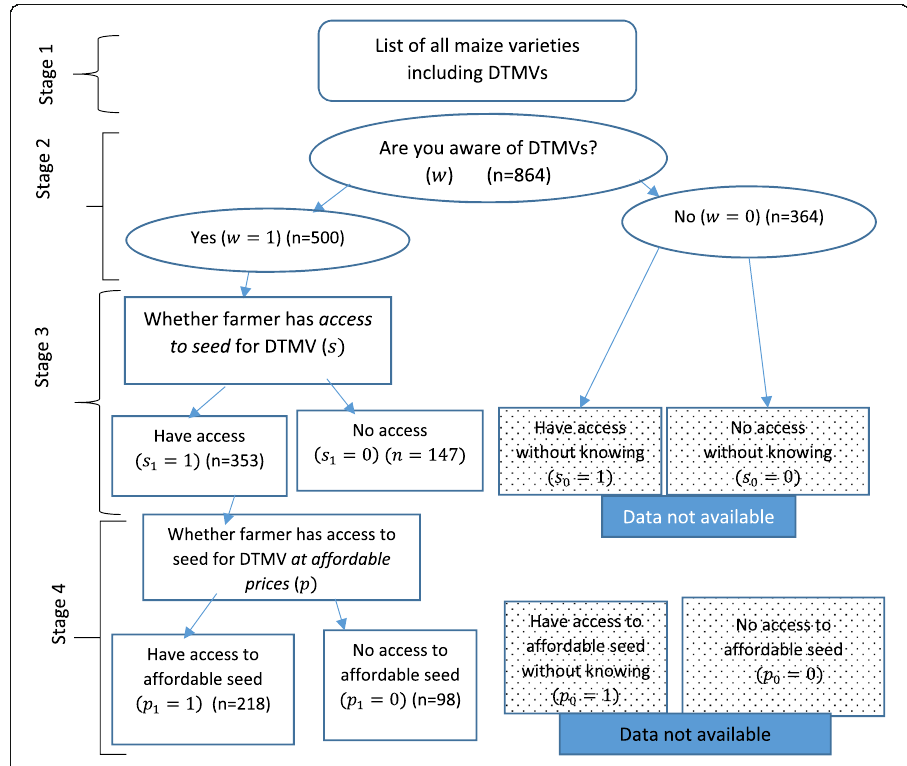
Fig. 1 Flowchart linking awareness, seed access and affordability